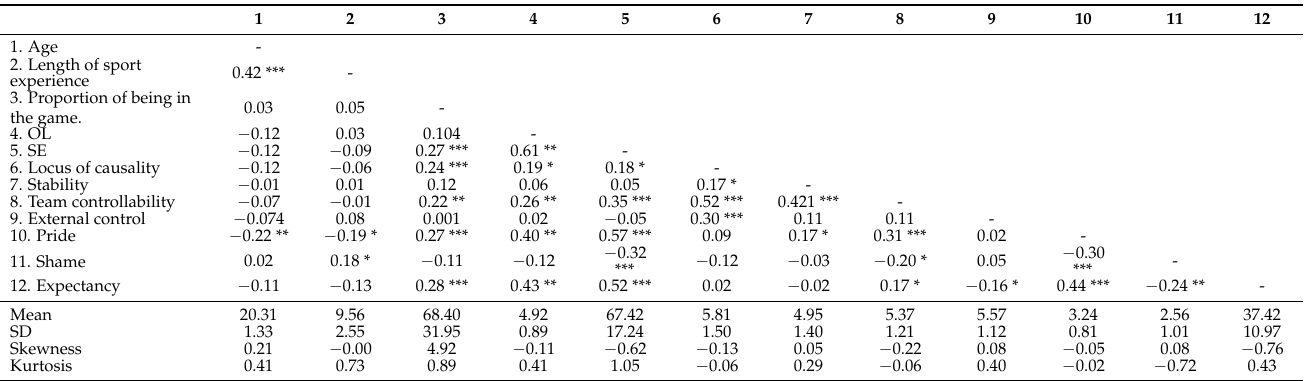
Table 4. Descriptive Statistical